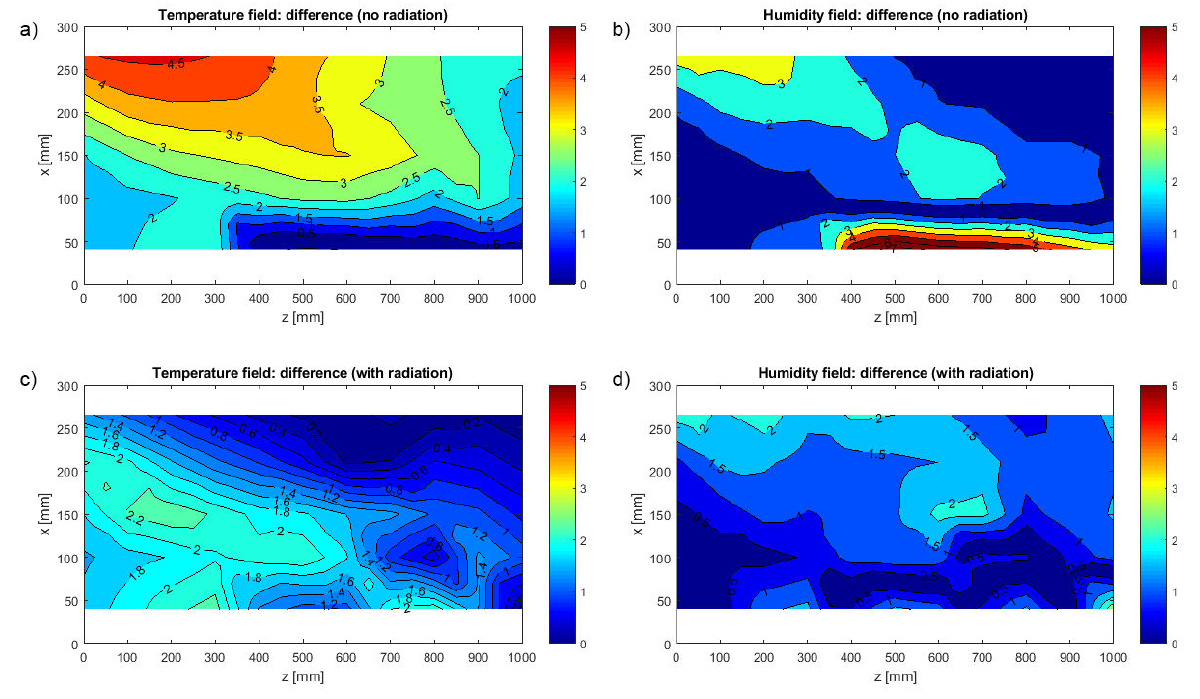
Fig. 8. Case 2 ( ∆ T = 20° C ): Comparison of experiment and CFD - measured field is subtracted from simulated field (absolute di ff erences are plotted), temperature di ff erences are in ° C (a,c); specific humidity di ff erences are in g v p / k g da (b,d)